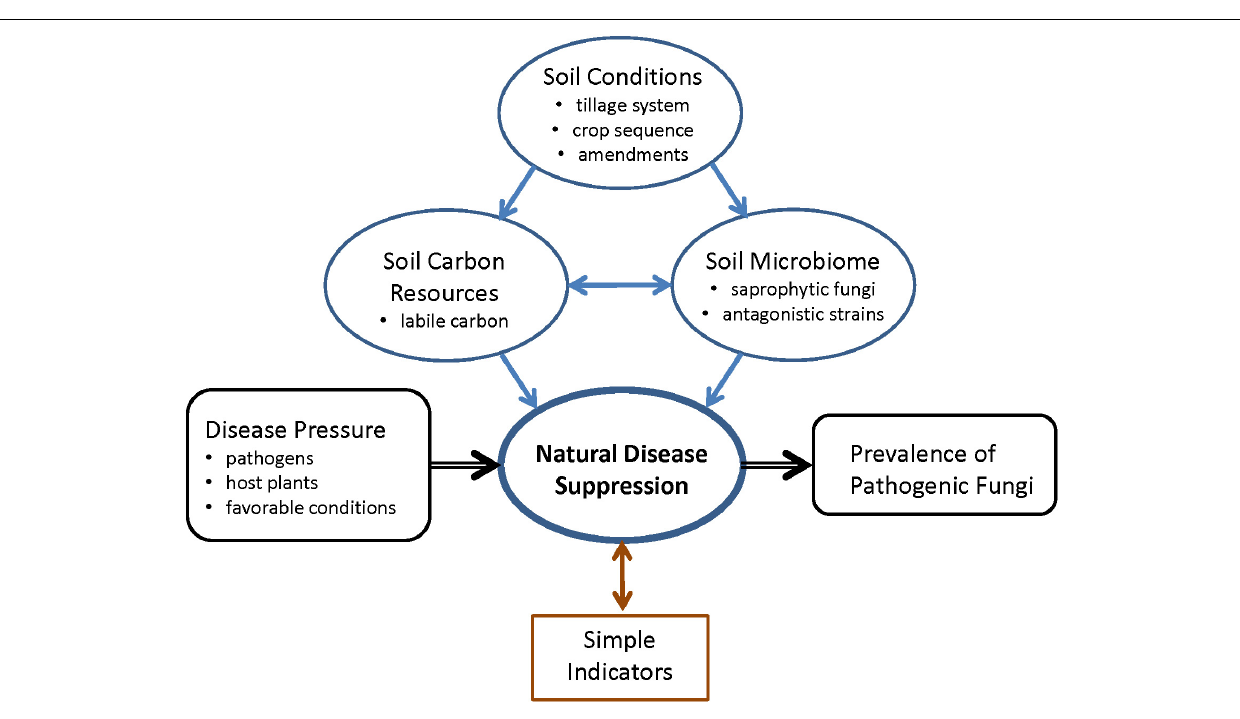
FIGURE 4 | Schematic summary of the study question, and the connections between soil conditions, soil carbon resources, soil microbiome, and natural soil disease